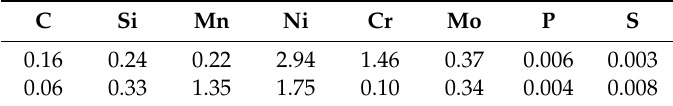
Table 1. Chemical compositions of base metal and filler metal (wt %).